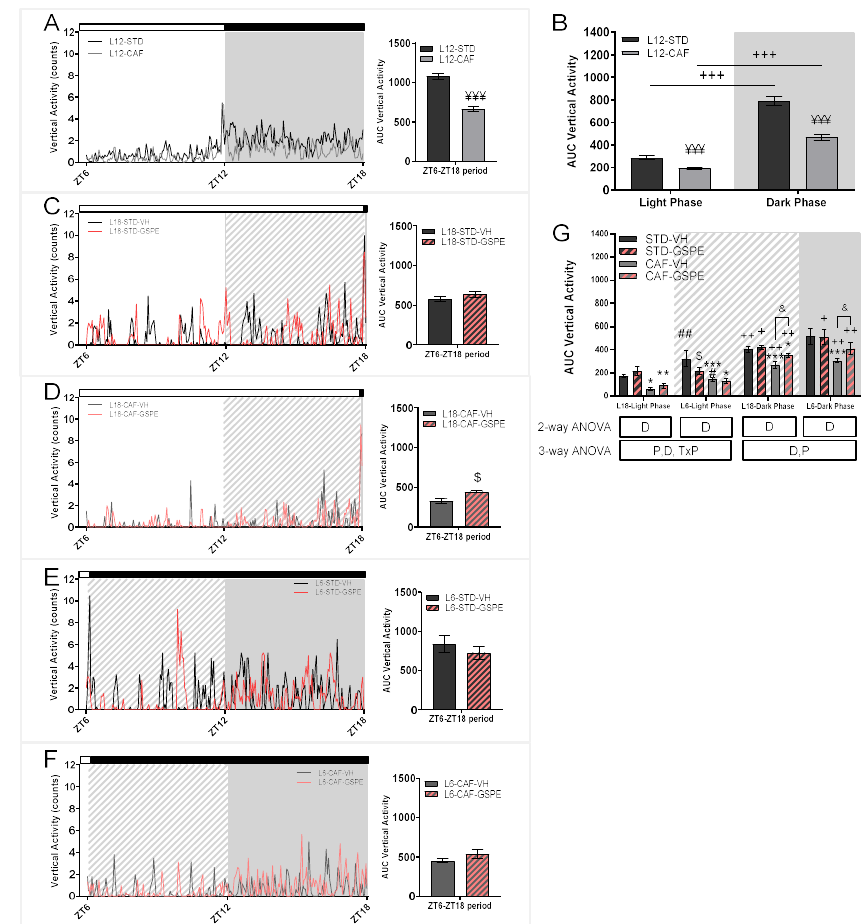
Figure 5. Activity of STD- and CAF-fed rats in the sixth week of the experiment under L12 conditions and in the seventh week of the experiment under L18 and L6 conditions. ( A ) Activity for STD- and CAF-fed rats under the L12 photoperiod and the corresponding AUC. ( B ) Activity for STD-fed rats administered VH or GSPE under the L18 photoperiod and the corresponding AUC. ( C ) Activity for CAF-fed rats administered VH or GSPE under the L18 photoperiod and the corresponding AUC. ( D ) Activity for STD-fed rats administered VH or GSPE under the L6 photoperiod and the corre- sponding AUC. ( E ) Activity for CAF-fed rats administered VH or GSPE under the L6 photoperiod and the corresponding AUC. ( F ) AUC of activity for L12 conditions groups with light phase and dark phase separated. ( G ) AUC activity for L6 and L18 conditions groups with light phase and dark phase separated. For L12 conditions, values are expressed as the mean ± S.E.M. ( n = 24). ¥¥¥ Indicates significant differences using an unpaired Student ´ s t -test between L12-STD vs. L12-CAF ( p ≤ 0.001). Values are expressed as the mean ± S.E.M. ( n = 6). D, diet effect; P, photoperiod effect; TxP, in- teraction between treatment and photoperiod. *, ** or *** Indicate significant differences by diet effect ( p ≤ 0.05, p ≤ 0.01 and p ≤ 0.001, respectively), $ Indicates significant differences by treatment effect, ## Indicate significant differences by photoperiod effect ( p ≤ 0.01, respectively) using 2-way and 3-way ANOVA followed by a LSD post-hoc test ( p ≤ 0.05). & Indicates tendency using a LSD